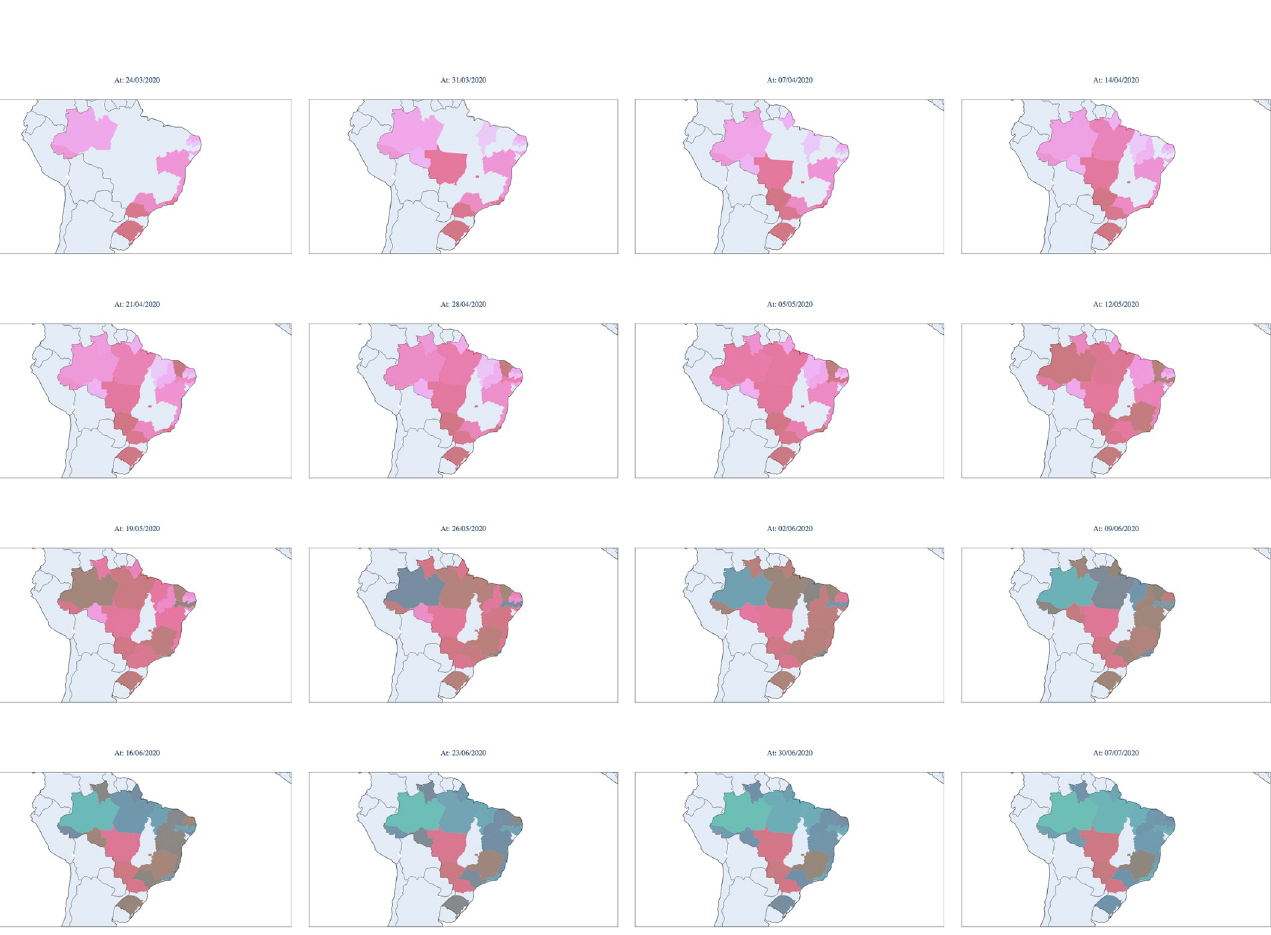
Fig 9. Estimated values of R t for each state during the epidemic period in Brazil. Starting in March 2020 (upper left corner) and concluding in September 2020 (lower right corner). The maps were generated in python using the Plotly library [24].